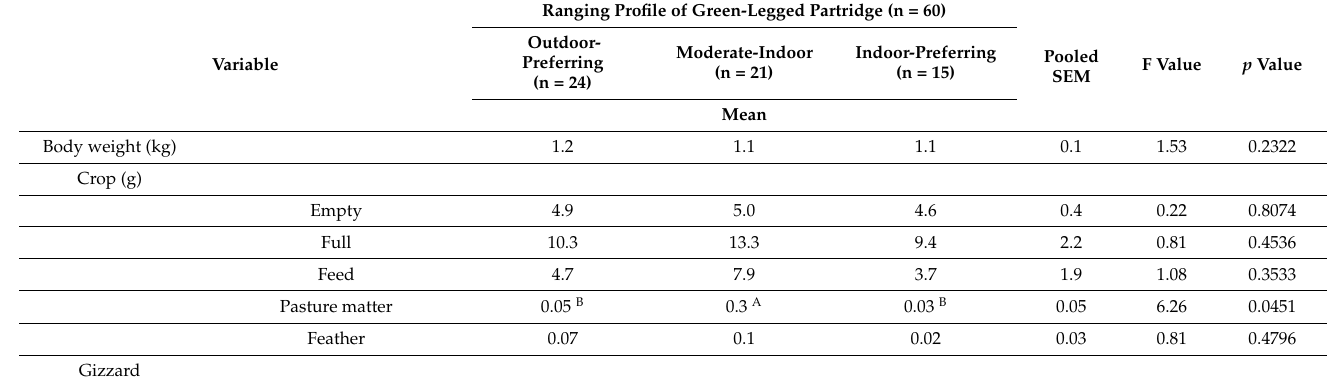
Table 1. The gastrointestinal tract morphometrics and content of green-legged partridge chickens with differing ranging profiles, presented as mean ± SEM and its associated test